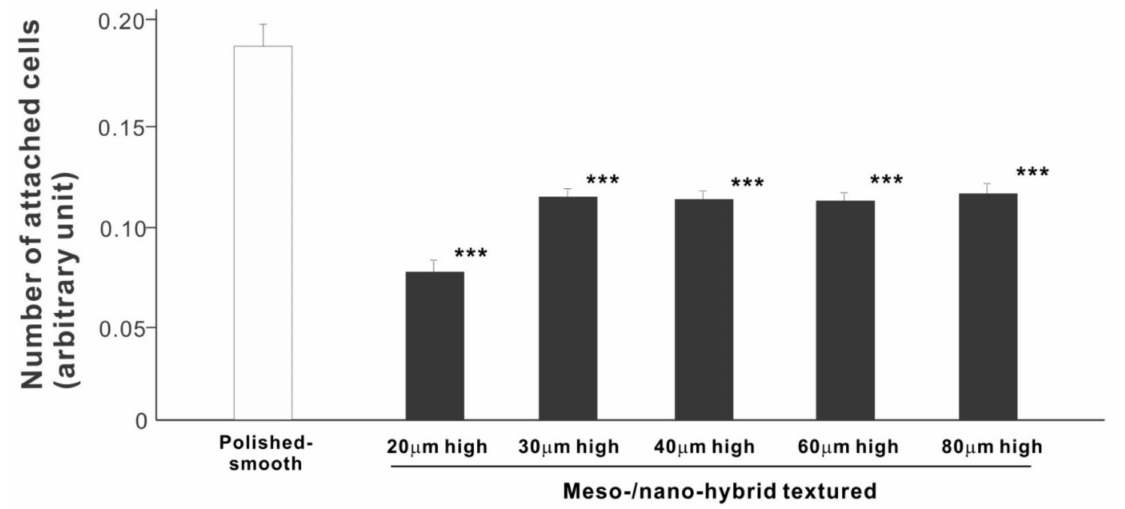
Figure 5. Attachment of osteoblasts to differently textured zirconia surfaces during the initial stage of culture, evaluated by WST-1 assay on day 2. *** p < 0.001, statistically significant difference compared with a polished